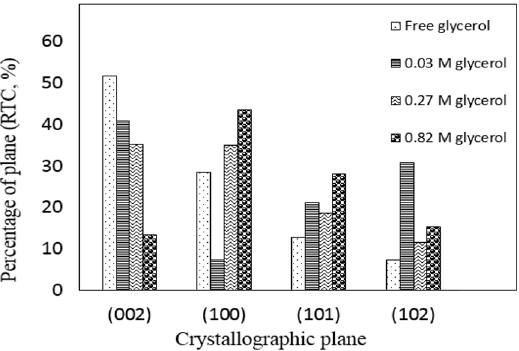
Figure 5. Percentage of RTC as a function of crystallographic planes of zinc coatings obtained in absence and presence of various glycerol contents Table 4. The microstrain of the compression of Zn coating in presence and absence of glycerol